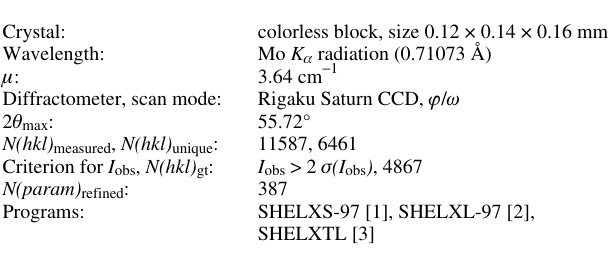
Table 1. Data collection and handling.